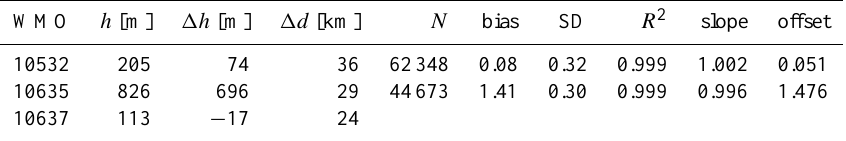
Table 2. Scatter plot properties for the different IWV measurements, calculated for the IGS station FFMJ (located at Frankfurt/Main, Ger- many, at an altitude of 130ma.s.l.) with surface observations from different WMO synoptic (SYNOP) stations. The reference WMO station has code 10637, also shown are the altitude and the height and horizontal distance from the IGS station FFMJ. WMO h [m] 1h [m] 1d [km] N bias SD R 2 slope offset 10532 205 74 36 62348